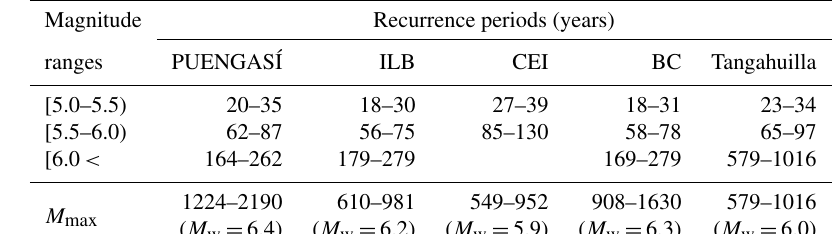
Table 3. Recurrence periods, Gutenberg–Richter-modified model.